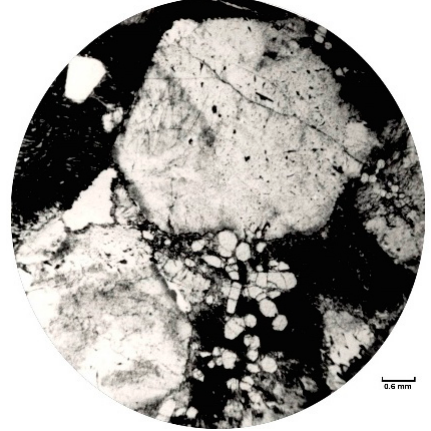
Figure 9. Thin section of massif urtite. Small crystals of apatite in interstitial between large crystals of nepheline.